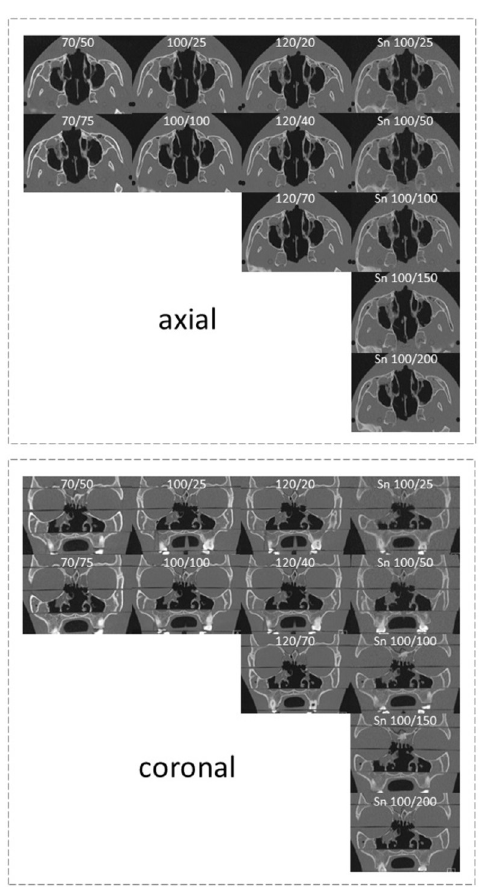
Fig 2. Example images of all examined protocols of the phantom study. Shown are CT-images in axial (upper panel) and coronal (lower panel) orientation. The used voltage (kV) and current (mAs) of each protocol are given at the top. Sn = tin